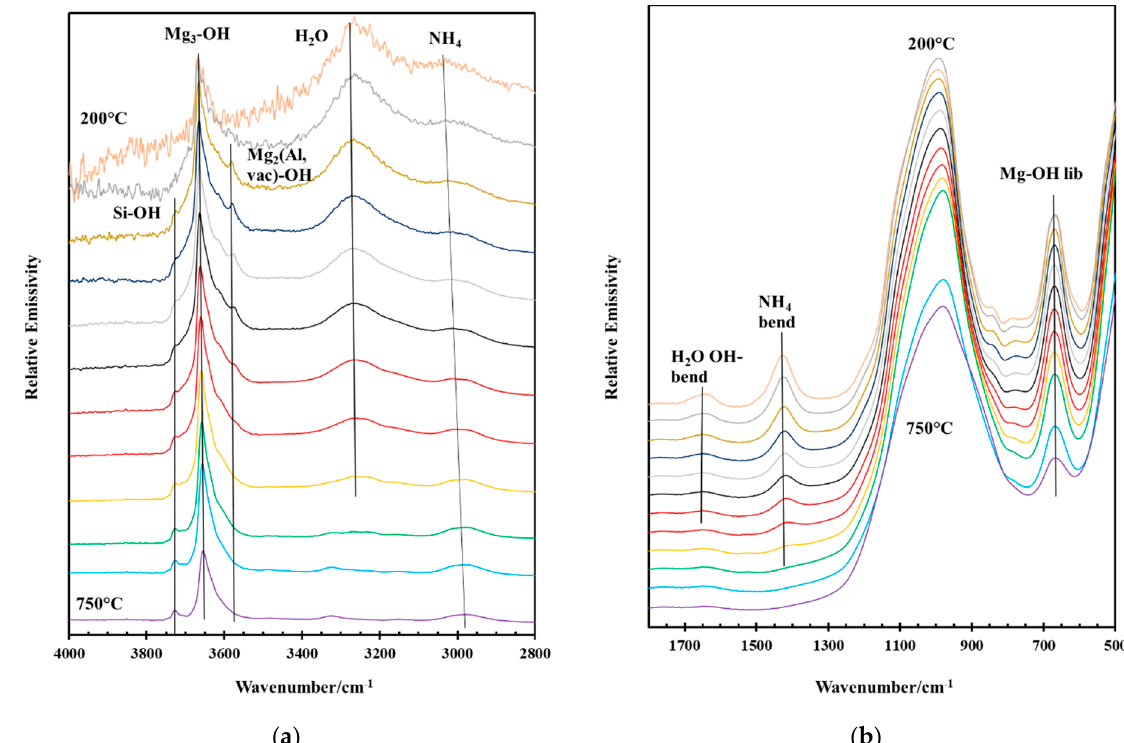
Figure 9. Infrared emission spectra of synthetic saponite HTSap1a between 200 and 750 °C at 50 °C intervals in the regions 4000–2800 cm − 1 ( a ) and 1800–500 cm − 1 ( b ) (modified after [52] ).